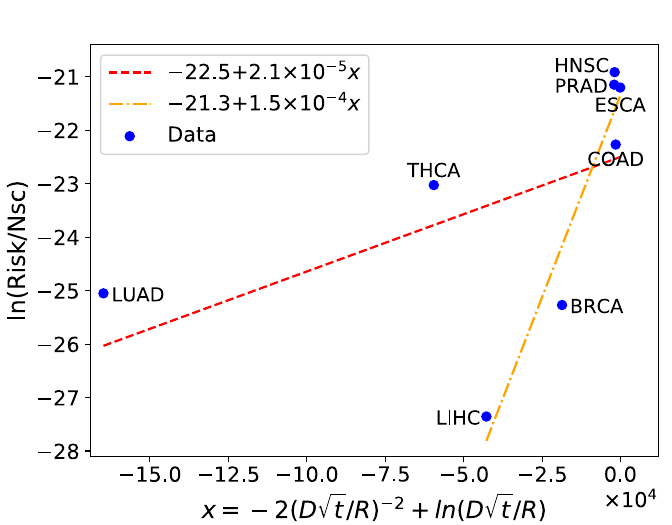
Figure 3. A test of how Eq. (6) describes the risk of cancer in 8 tissues. Data from Table 2 is used to this end. A very small slope is obtained in both, the full fit and a fit without LUAD and THCA, thus small amplitude fluctuations in gene expression space may not account for the risk of cancer in these